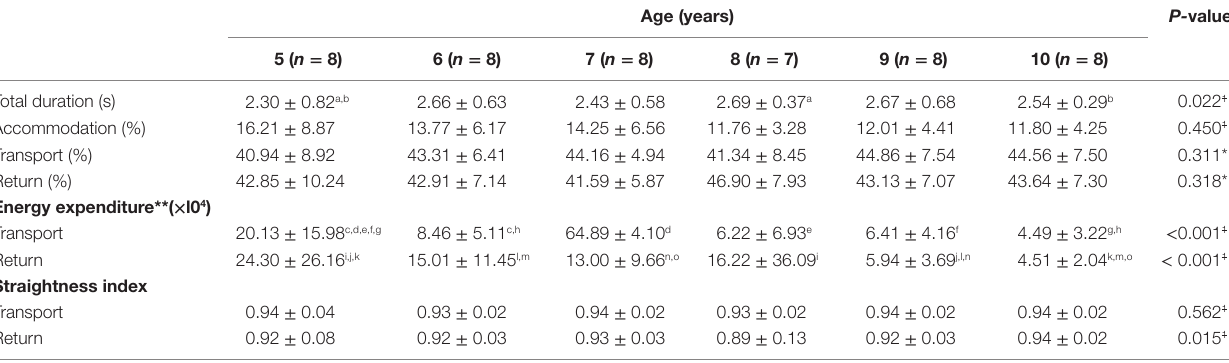
TABle 2 | Spatial-temporal parameters regarding age of the